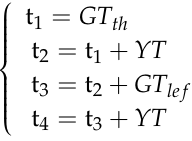
Figure 5. The northbound signal phases.